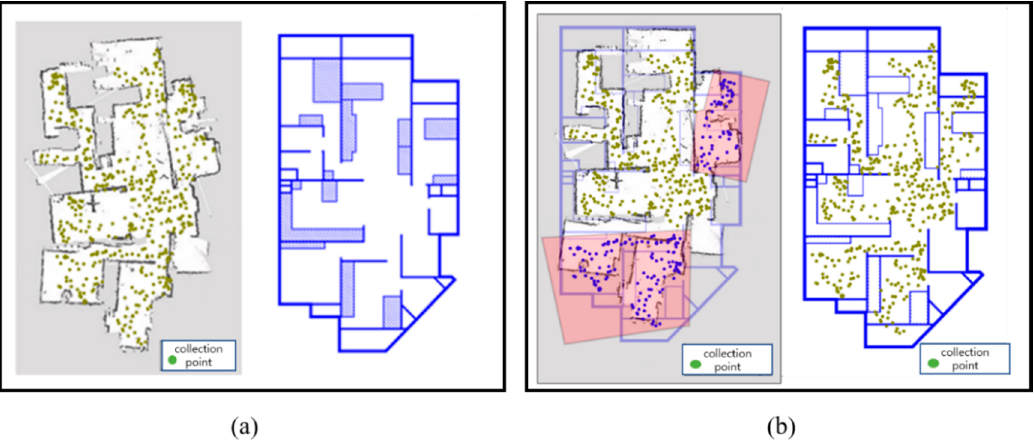
Table 1. Transformation matrix for the map correction.